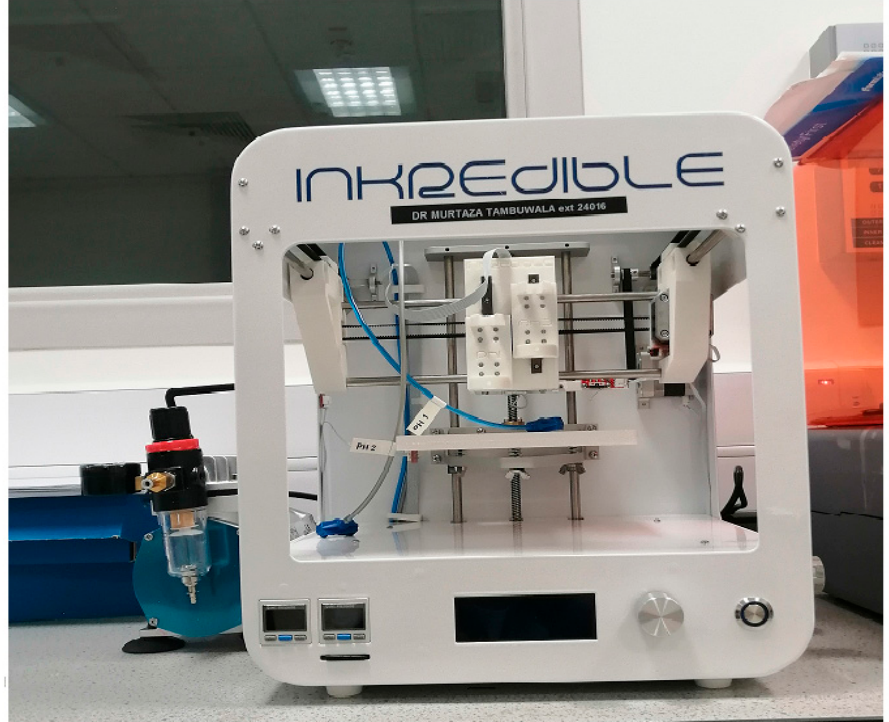
Figure 1. Illustration showing the pneumatic based extrusion Inkredible 3D bioprinter (dual-print head). The bioprinter employed had a UV LED curing system, which assists in bio-printing tissues or any organ model.